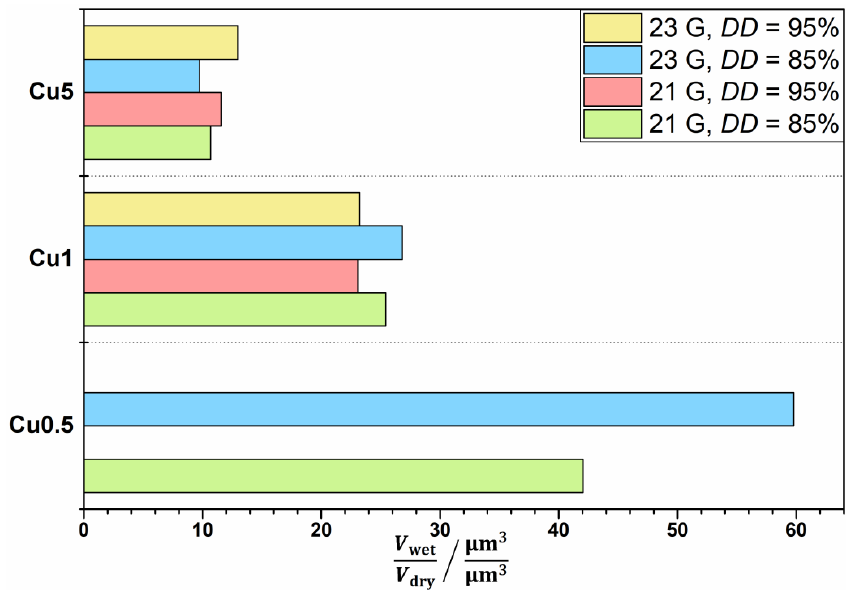
Figure 6. The estimated volume ratio (water content) of chitosan–Cu 2+ complex